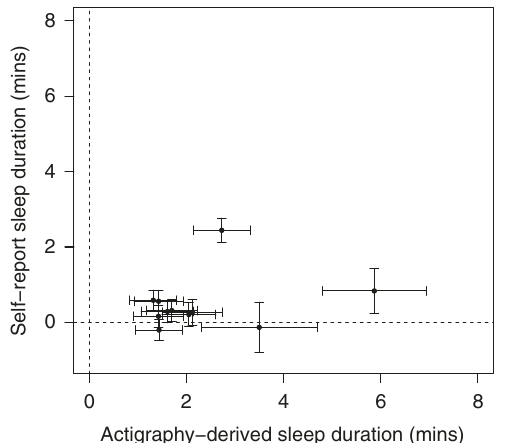
Fig. 1 Comparison of SNP effect estimates on accelerometer and self-report sleep duration. The effects for 11 genetic variants associated with accelerometer-derived sleep duration against effect estimates from a parallel GWAS of self-report sleep duration 14 are presented. Error bars represent the 95% con fi dence intervals for each effect estimate